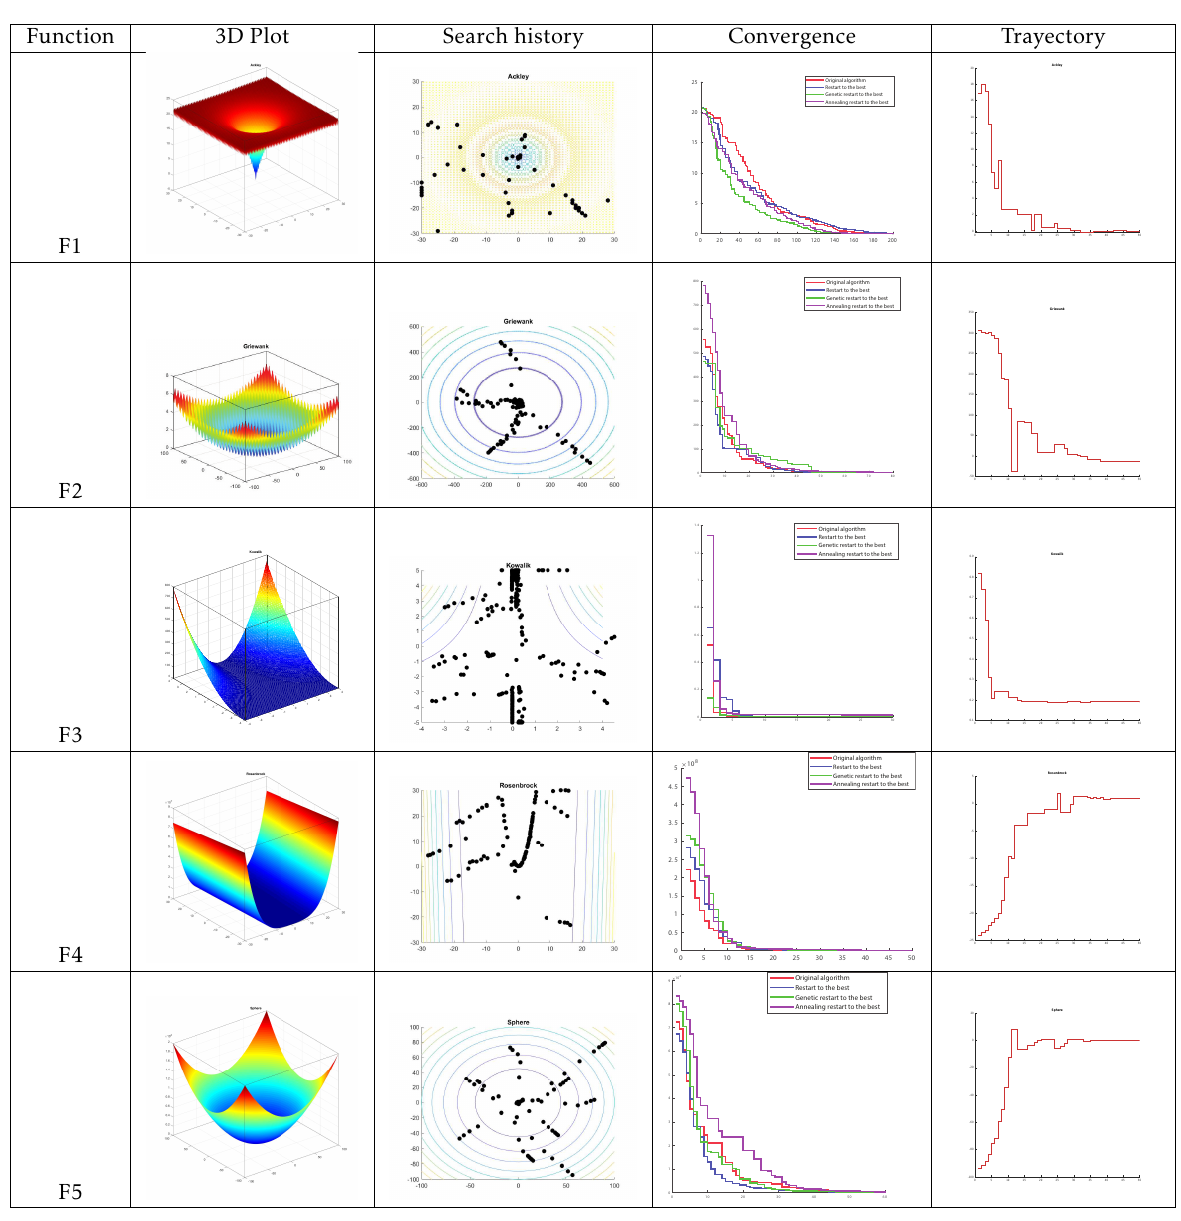
Table 5. Behavior of raindrops inside the benchmark